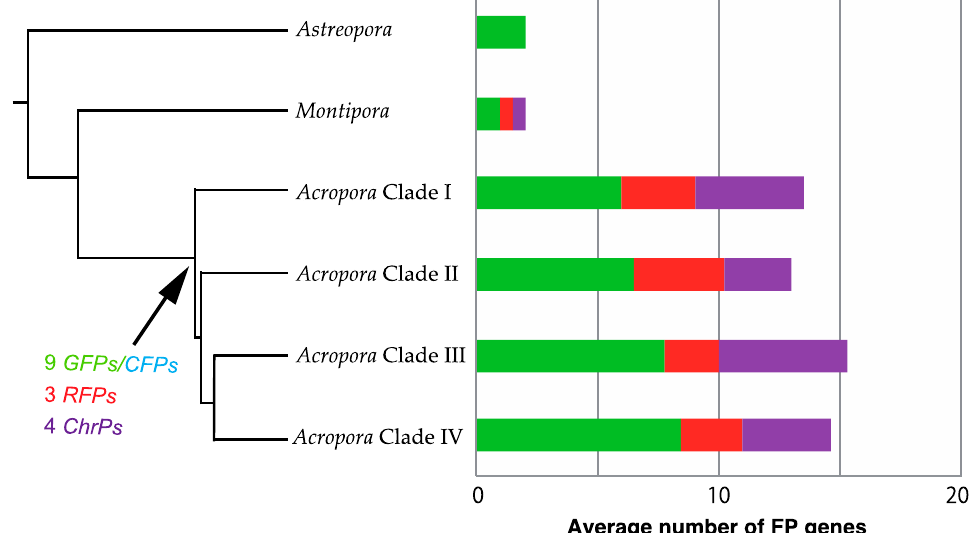
Figure 4. Estimated numbers of fluorescent genes in the Acropora ancestor and diversification in the descendant lineages. It is hypothesized that ~16 FP genes have been conserved in Acropora . RFP and GFP/CFP genes may have diversified more in Clades II and IV, respectively.